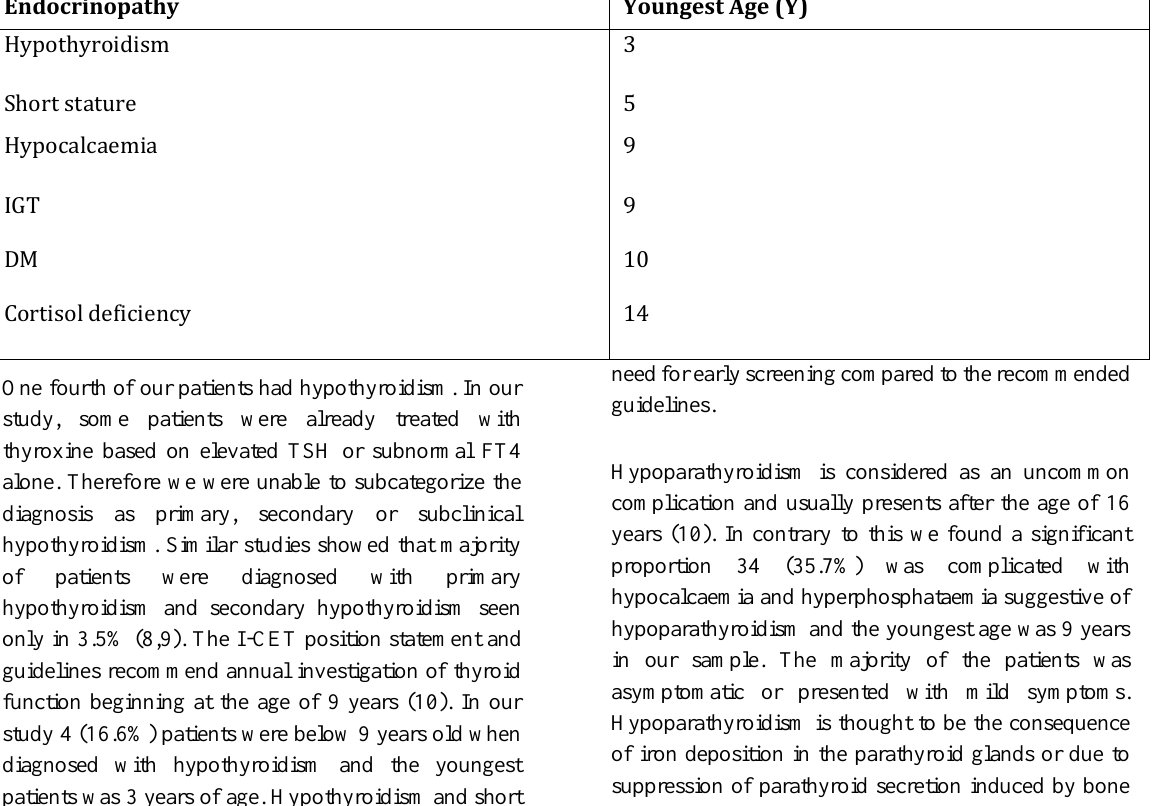
Table 4 – Youngest age in the sample of patients with thalassaemia major attending to Teaching Hospital Batticaloa, Sri